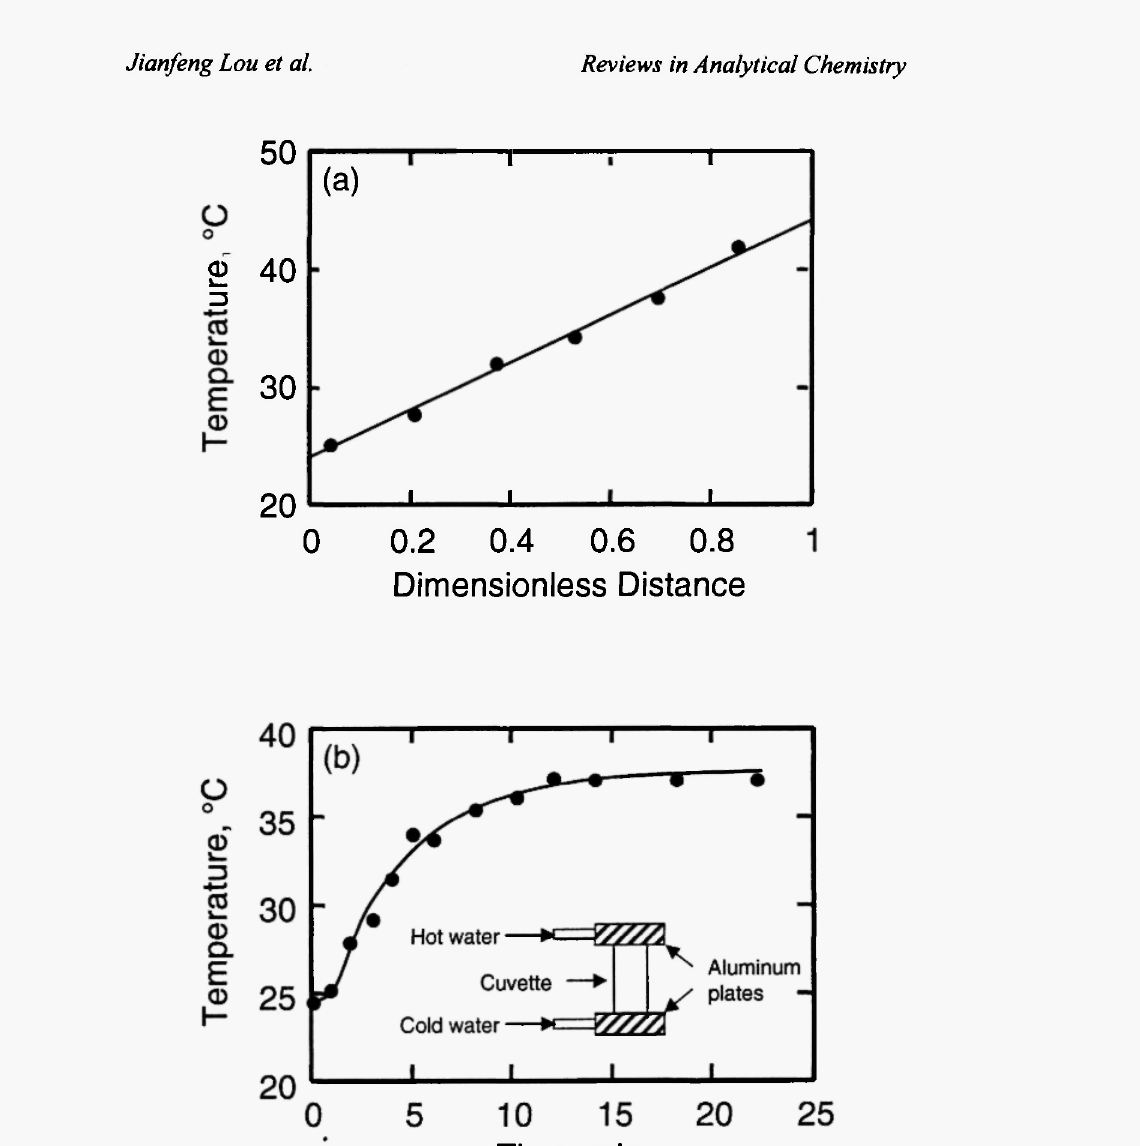
Fig. 11: Experimental results for a 1-D system characterized by fluorometric thermometry using PMPBA as a probe, a) A 1-D steady-state temperature experiment where the ends of a vertically oriented cuvette were at 25 and 45° C. b) The fluorometrically measured temperature at a point 3/8 along the height of a cuvette for a system equilibrated to 25° C and then subjected to a temperature jump to 55° C on its top side. A schematic of the apparatus is shown in the inset.